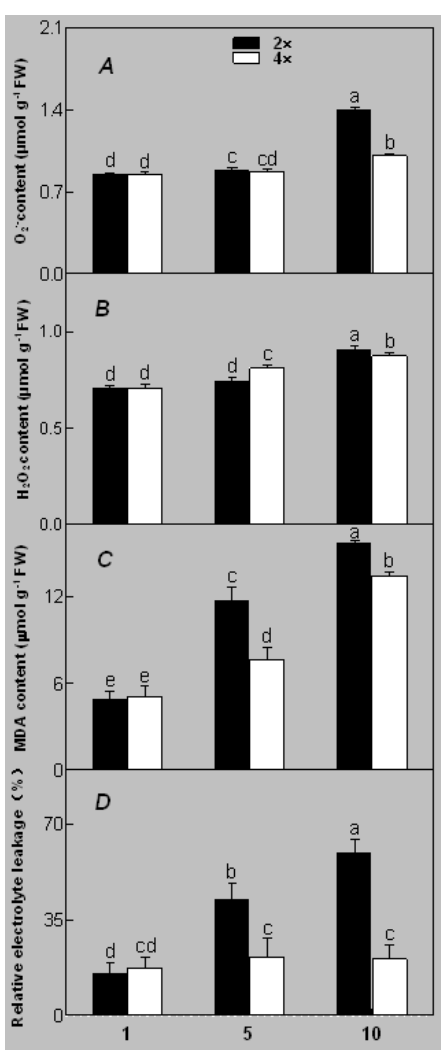
− content ( A ), H Figure 3. Effects of salt stress on O O content ( B ), and malondialdehyde 2 2 2 (MDA) content ( C ) and relative electrolyte leakage (REL) ( D ) in the leaves of Robinia pseudoacacia diploid (2×) (black bars) and tetraploid (4×) (white bars) plants growing under salt stress. Values followed by different letters are significantly different from each other at p < 0 . 05 according to Duncan’s method. Each data point represents the mean ± standard error of three